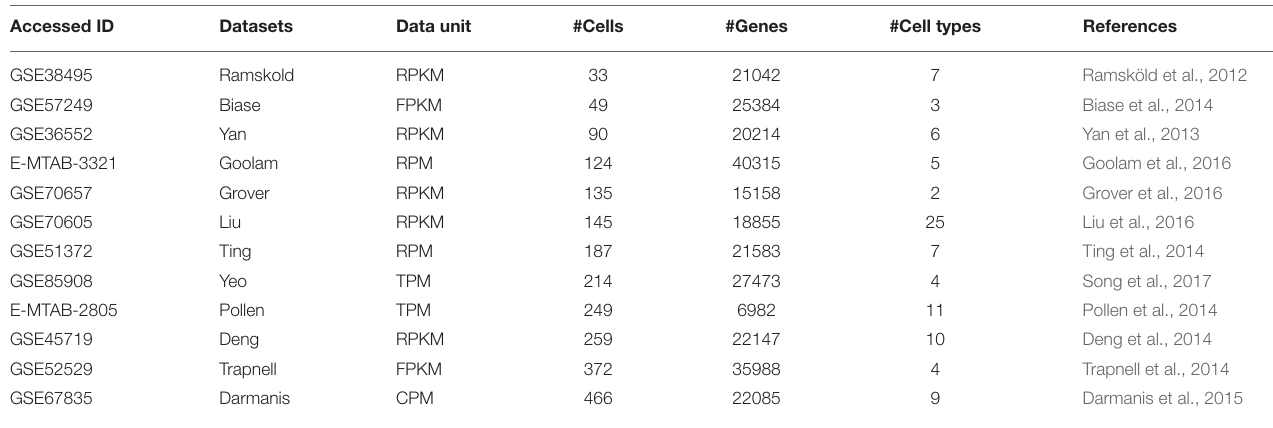
TABLE 1 | The detail of scRNA-seq